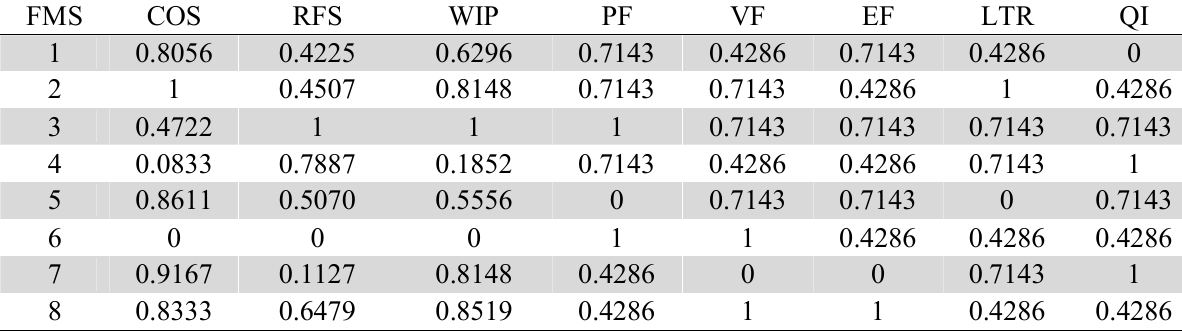
Normalized decision matrix for the FMS selection